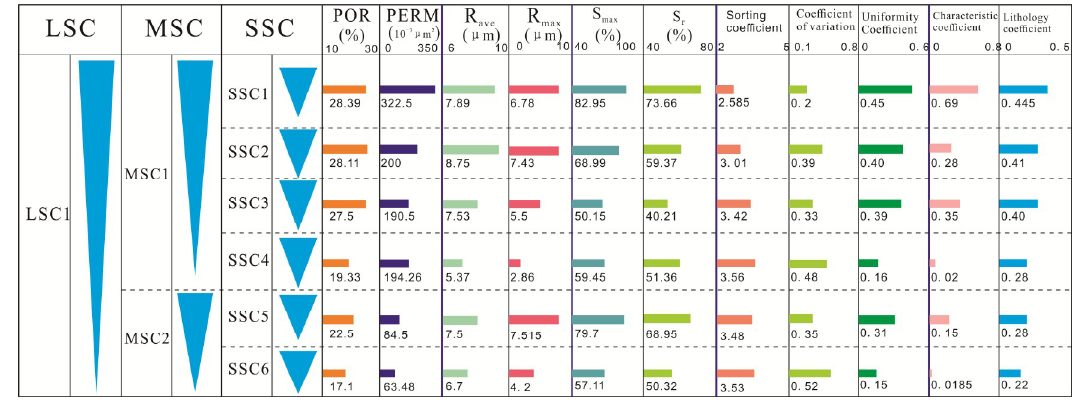
Figure 15. Relationship diagram between the pore structure of mouth-bar sand bodies and MSC.